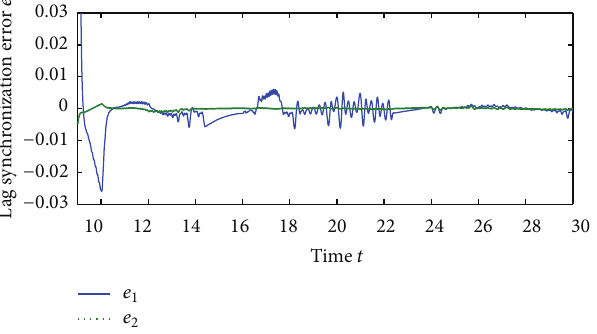
Figure 2: Synchronization error curve with 𝑇 = 8 , 𝜎 = 0.8 , and 𝑘 = 20